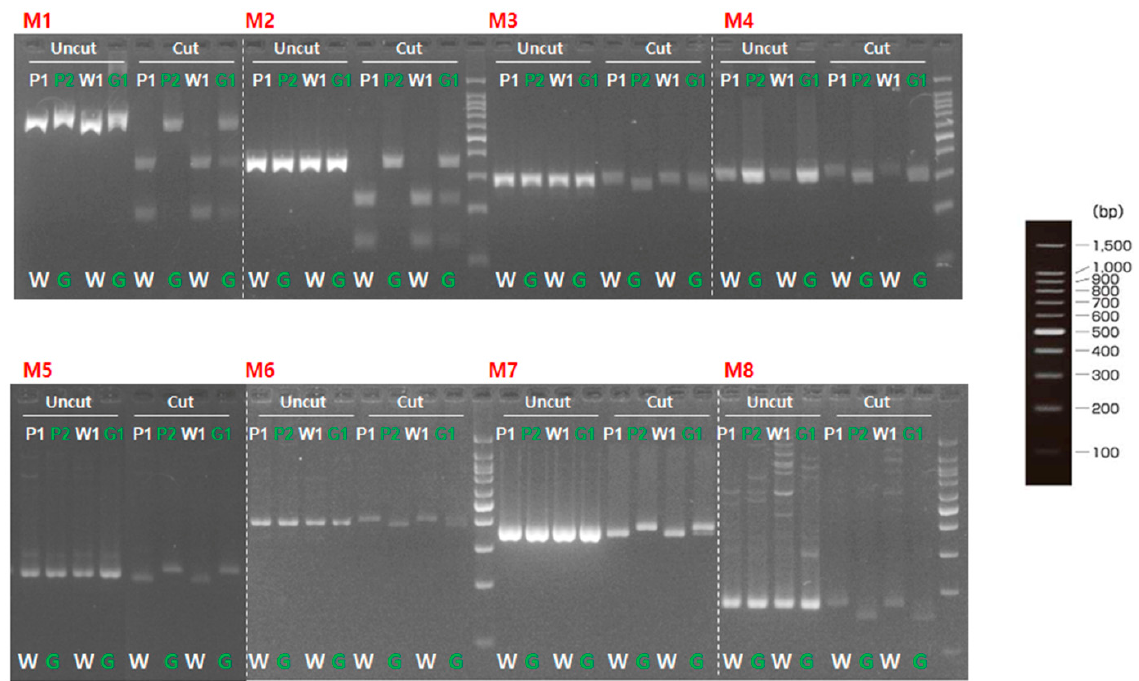
Figure 3. Marker validation with parental lines and bulked F 2 plants. P1, ‘PI525075’ (white); P2, ‘MEJ’ (light-green); W1, white pool, G1, light-green pool; W, white; G, light-green.